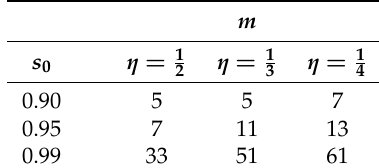
Table 6. Values of m evaluated by Equation (39) for each s 0 and η selected in Table 5.